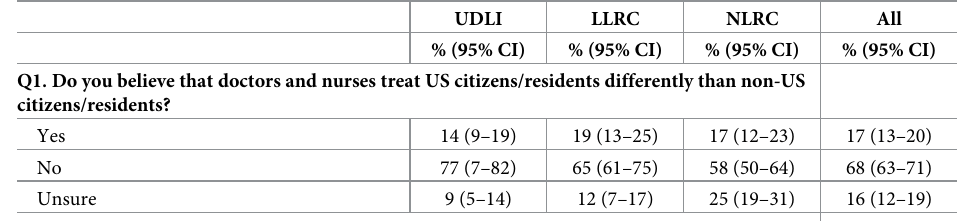
Table 2. Responses to key questions sorted according to study